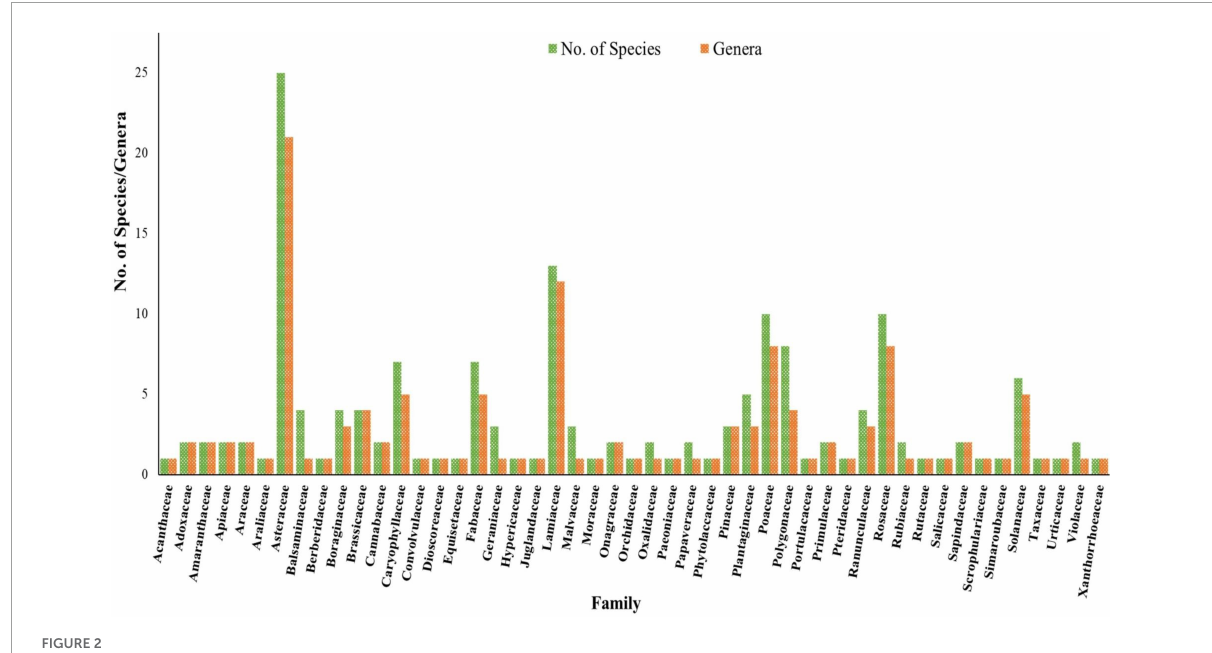
FIGURE2 Number of species and genera present in different families recorded across study sites.